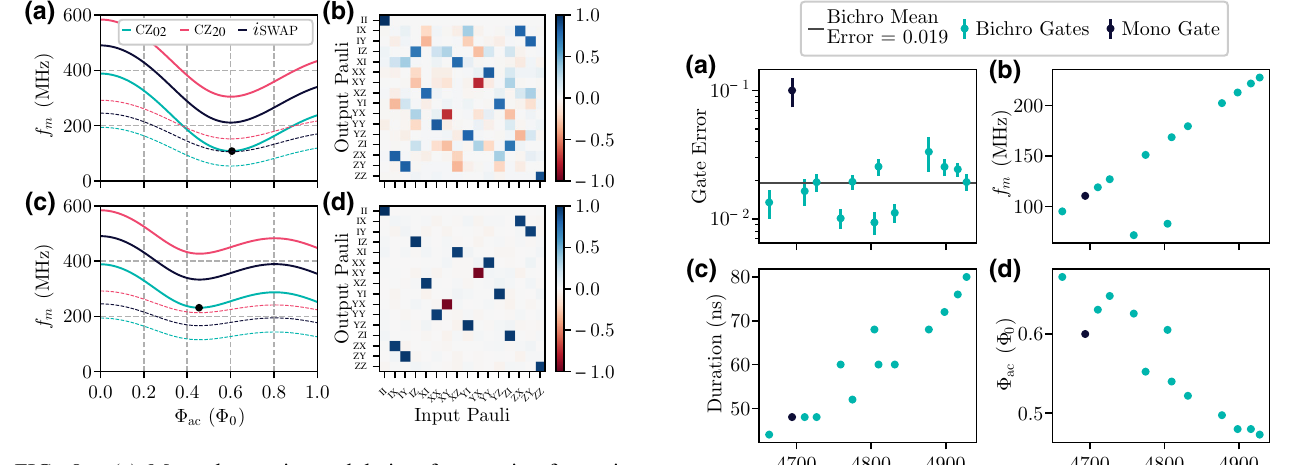
FIG. 8. (a) Monochromatic modulation frequencies for acti- vating native entangling gates between qubits 3 and 4 (ref. Table I) with the k = − 2 (solid lines) and k = − 4 (dashed lines) sidebands at different modulation amplitudes. A collision is found between the k = − 2 CZ 02 and k = − 4 i SWAP interactions at the sweet spot. (b) Measured process map for the optimized monochromatic CZ 02 pulse, generated via process tomography.